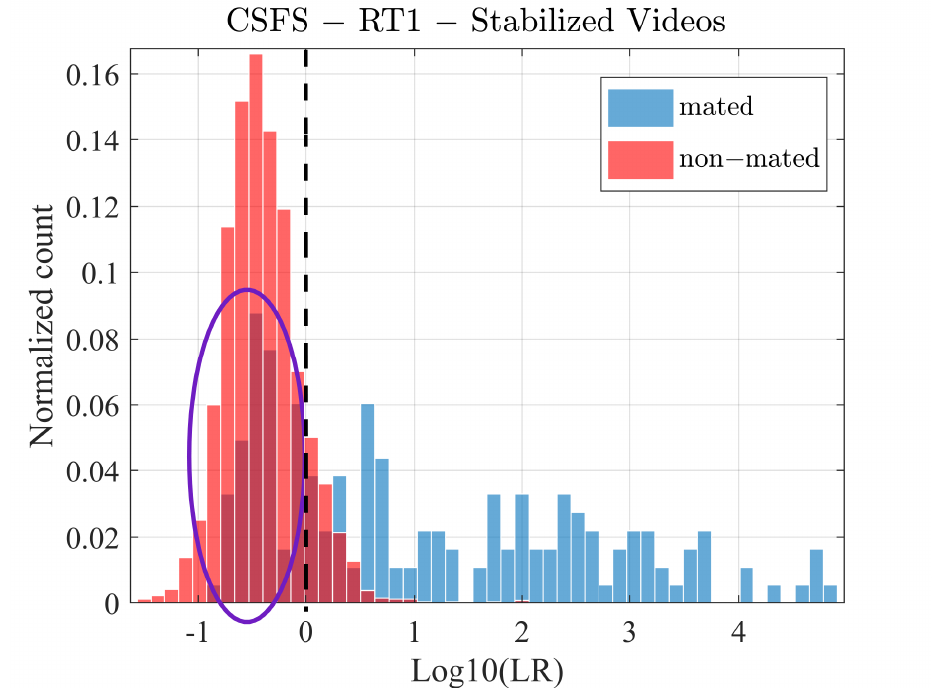
Figure 11. Likelihood ratio distribution after the linear logistic regression calibration. Magenta ellipse indicates the issue with the mated scores, black line shows log 10 ( LR ) = 0.